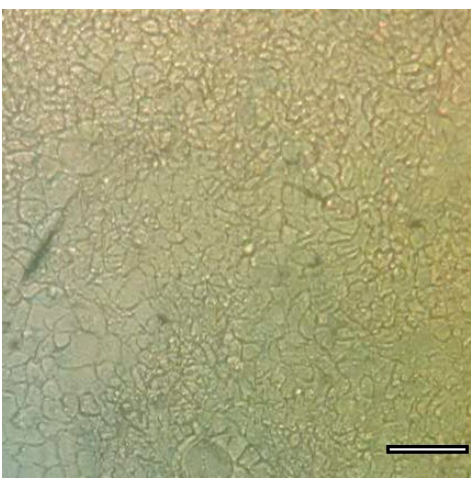
Figure 4. Caco-2 cells used for drug studies (scale bar = 100 μ m).